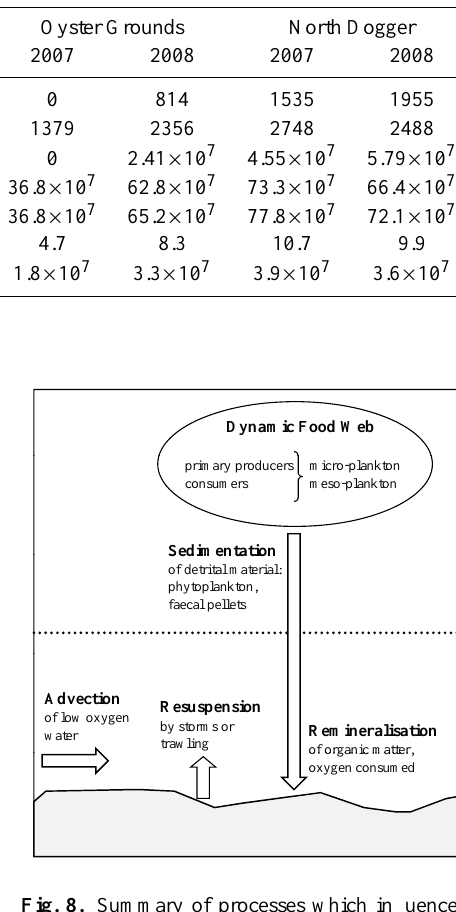
Table 6. Estimates of the volume of sediment trawled at Oyster Grounds and North Dogger in 2007 and 2008 by the UK over 15m fishing fleet.